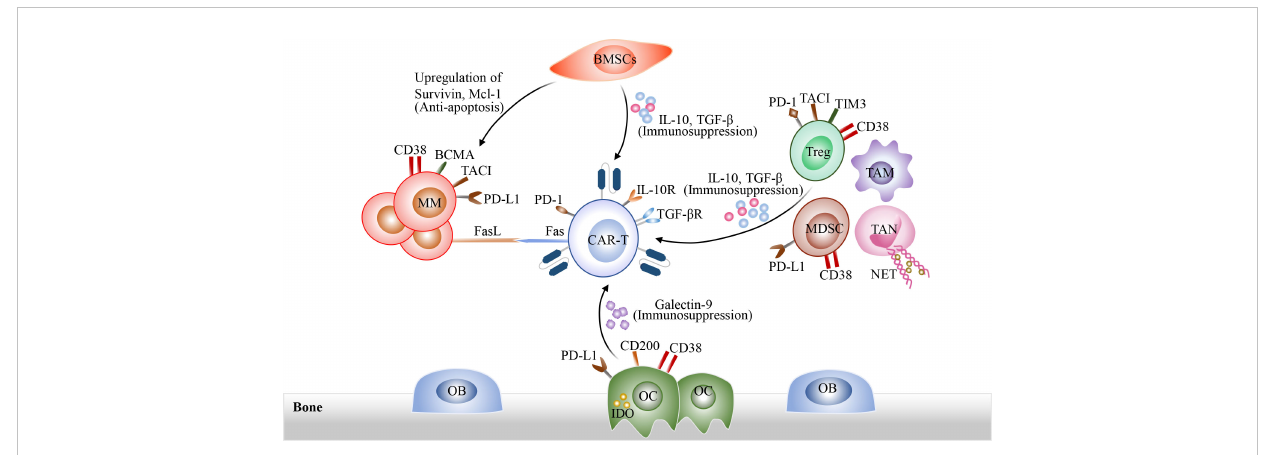
FIGURE 3 The interactions among CAR-T cells, tumor cells and immunosuppressive tumor microenvironment. On the one hand, tumor cells and immunosuppressive cells in bone marrow microenvironment induce CAR-T cell exhaustion through direct cell-to-cell contact, such as PD-1/PDL-1 pathway and Fas/FasL pathway. Immunosuppressive cells could also release immune inhibitory cytokines such as IL-10 and TGF- b to impact the cytotoxicity of CAR-T cells and promote the generation of Treg cells. In addition, BMSCs could protect MM cells against CAR-T cells through the up-regulation of anti-apoptosis proteins in MM